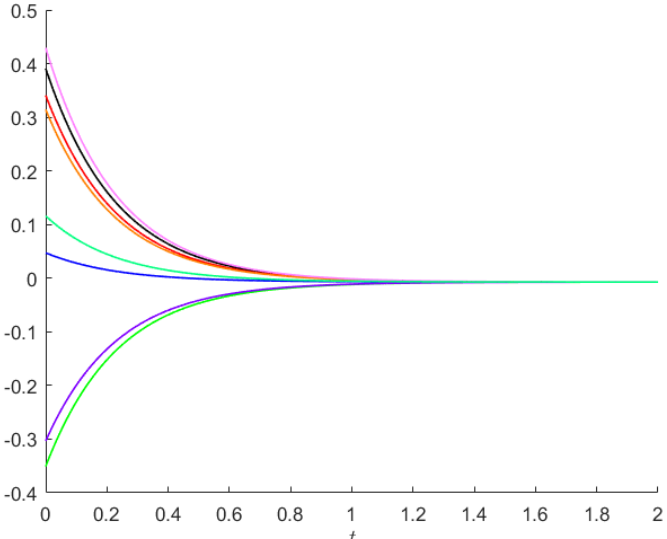
Figure 3. For Example 2, from 8 initial values (each shown using a separate color), are depicted the trajectories of state χ 1 .